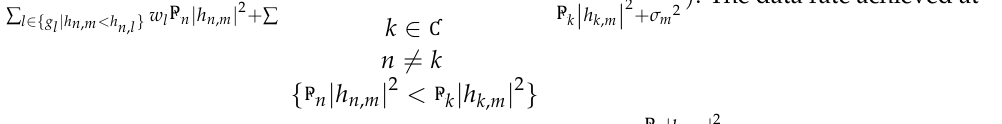
Table 2. Notations.